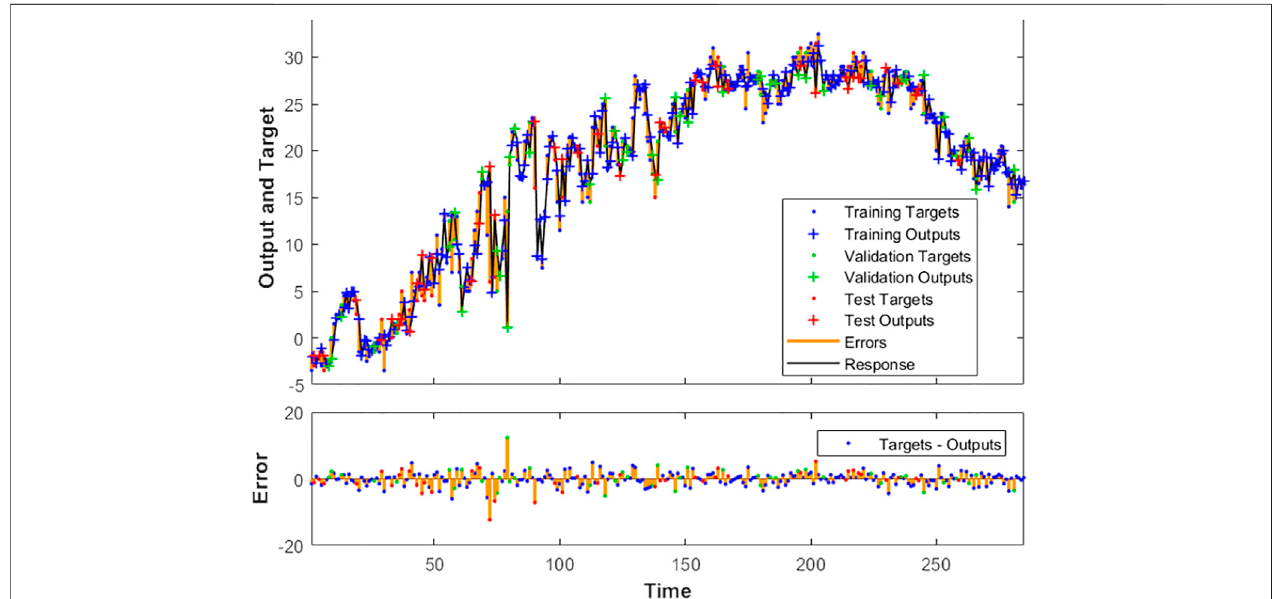
FIGURE 4 | Network